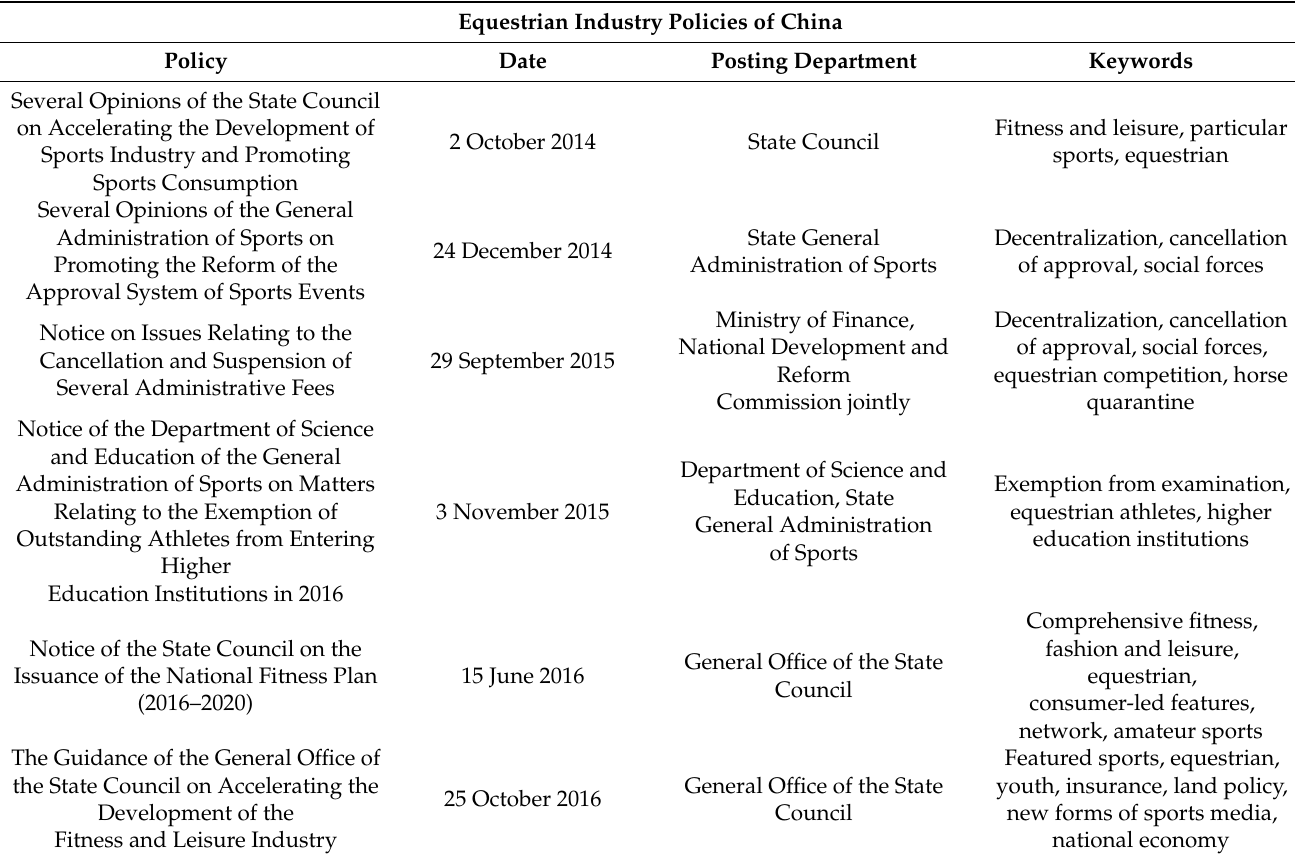
Table 1. Overview of China’s equestrian policies